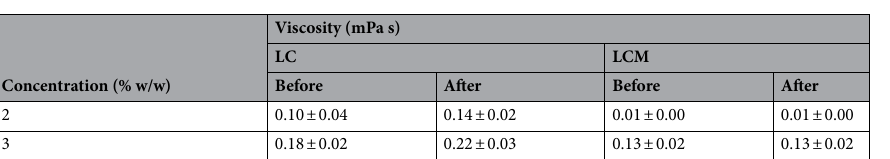
Table 2. Viscosity of lamellar liquid crystals (LLCs) using various surfactant types and amounts before and after eight heating–cooling cycles to determine stability. LC, C20–22 alkyl phosphate and C20–22 fatty alcohol (Runemul TM Favor LC); LCM, sorbitan stearate and sucrose cocoate (Liquid Crystal Cream